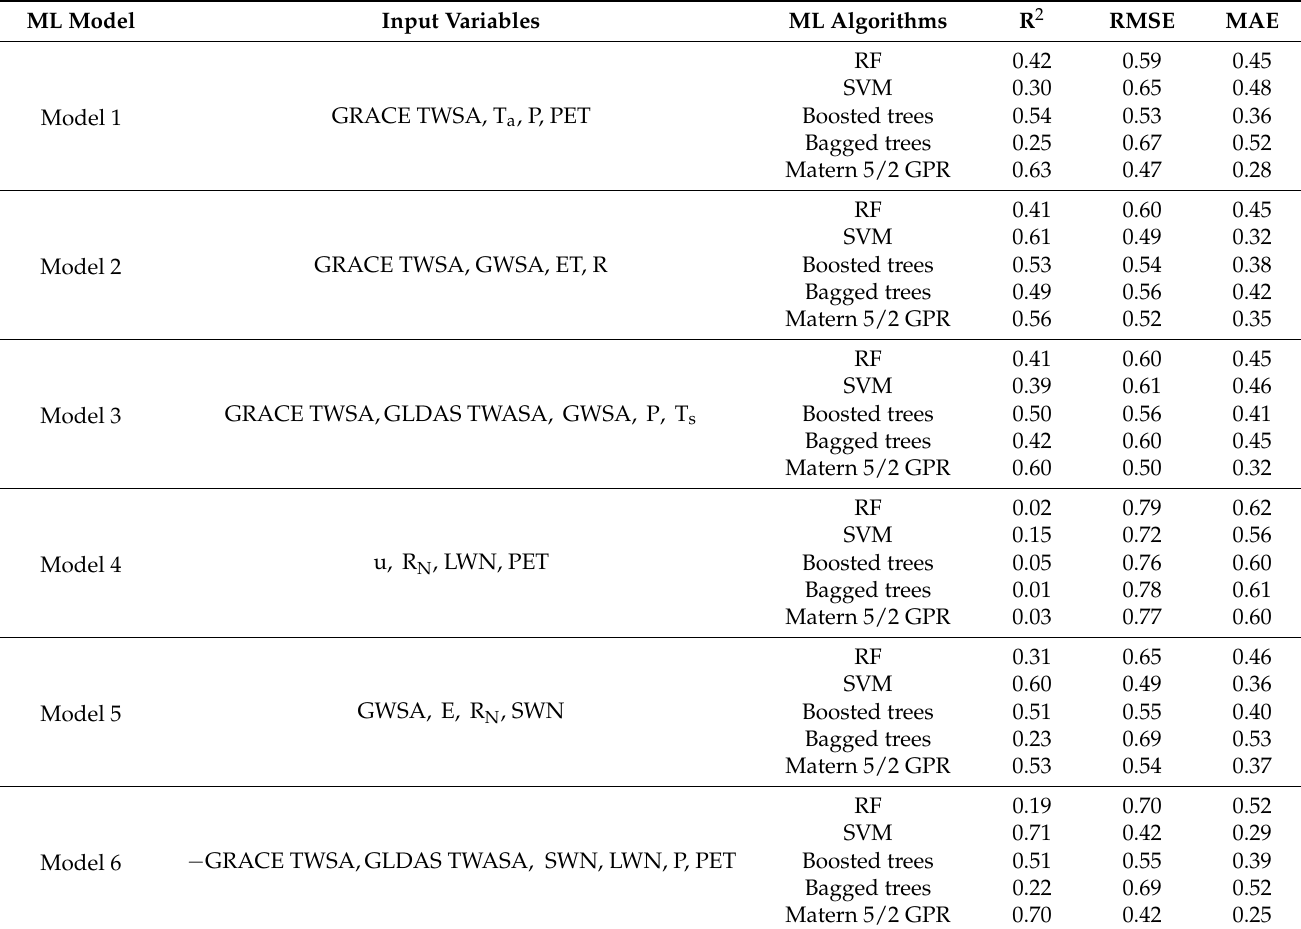
Table 2. The effectiveness of the considered models for the Combined Terrestrial Evapotranspiration Index (CTEI) estimate in the Ganga